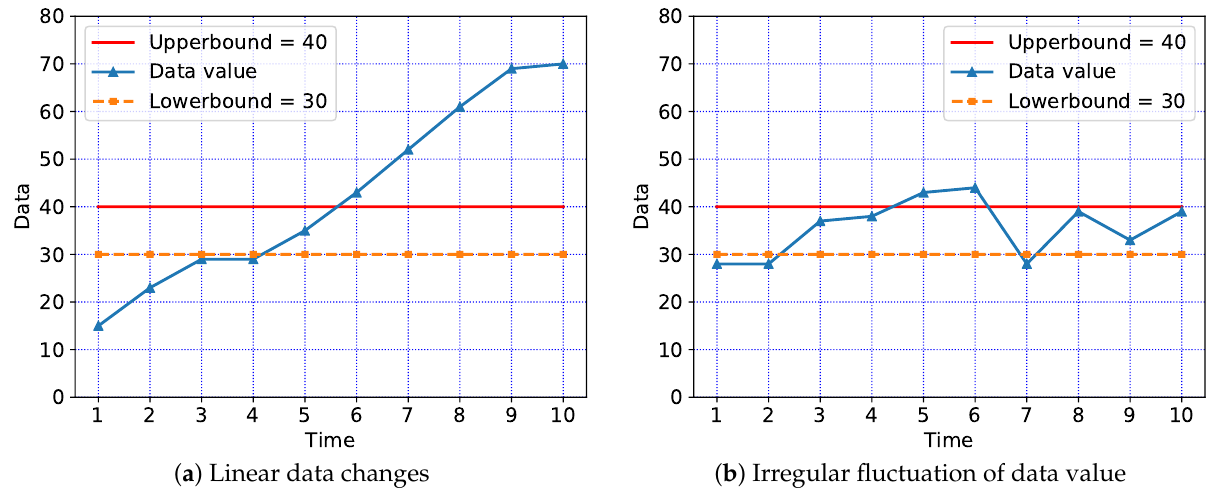
Figure 7. Data change trend of sensors in underground mining. The difference between the data at any adjacent time indicates the changing trend of the data. For two data d i and d j ( j = i + 1 ) at adjacent moments, if d j − d i > 0, the data shows an upward trend, otherwise the data shows a downward trend. As for the overall data, the sum of difference of adjacent data can obtain a trend estimation of data change. For data set D , we have,